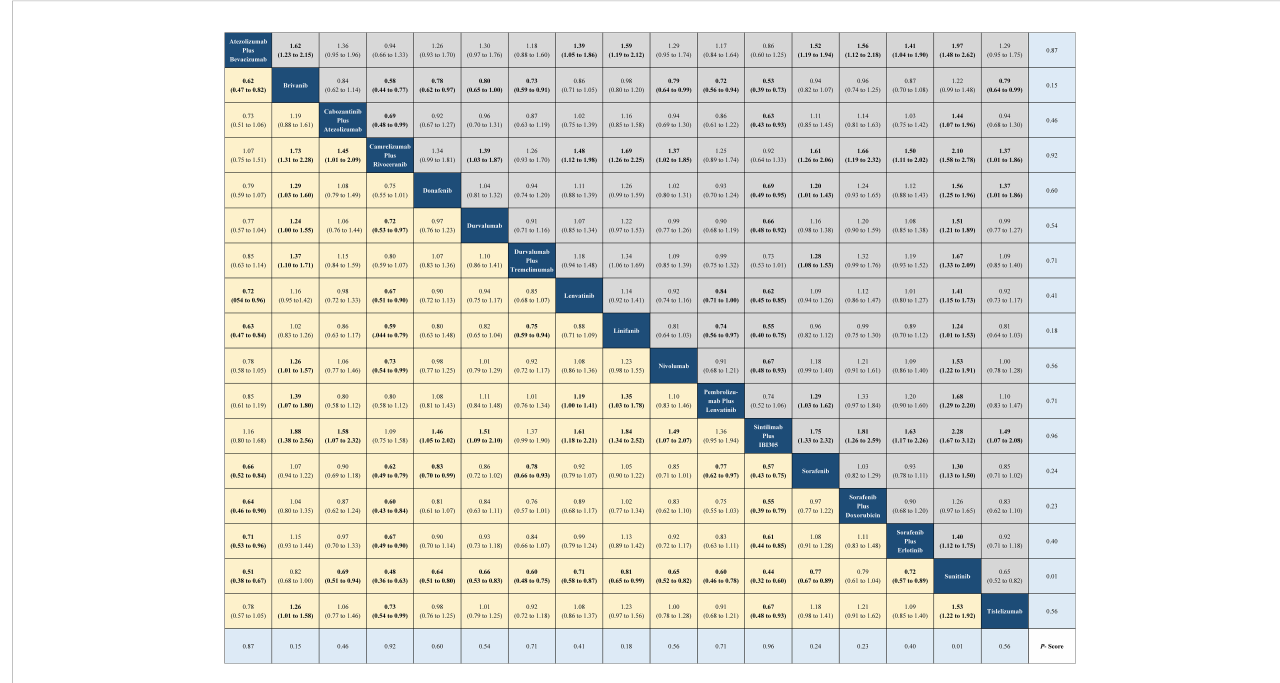
FIGURE 1 Network meta-analysis for overall